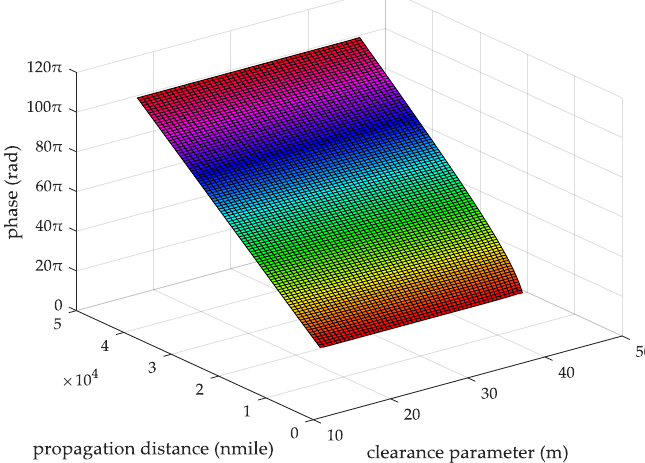
Figure 9. The ASFs of the AIS received signal changing with the propagation distance and clearance parameter.